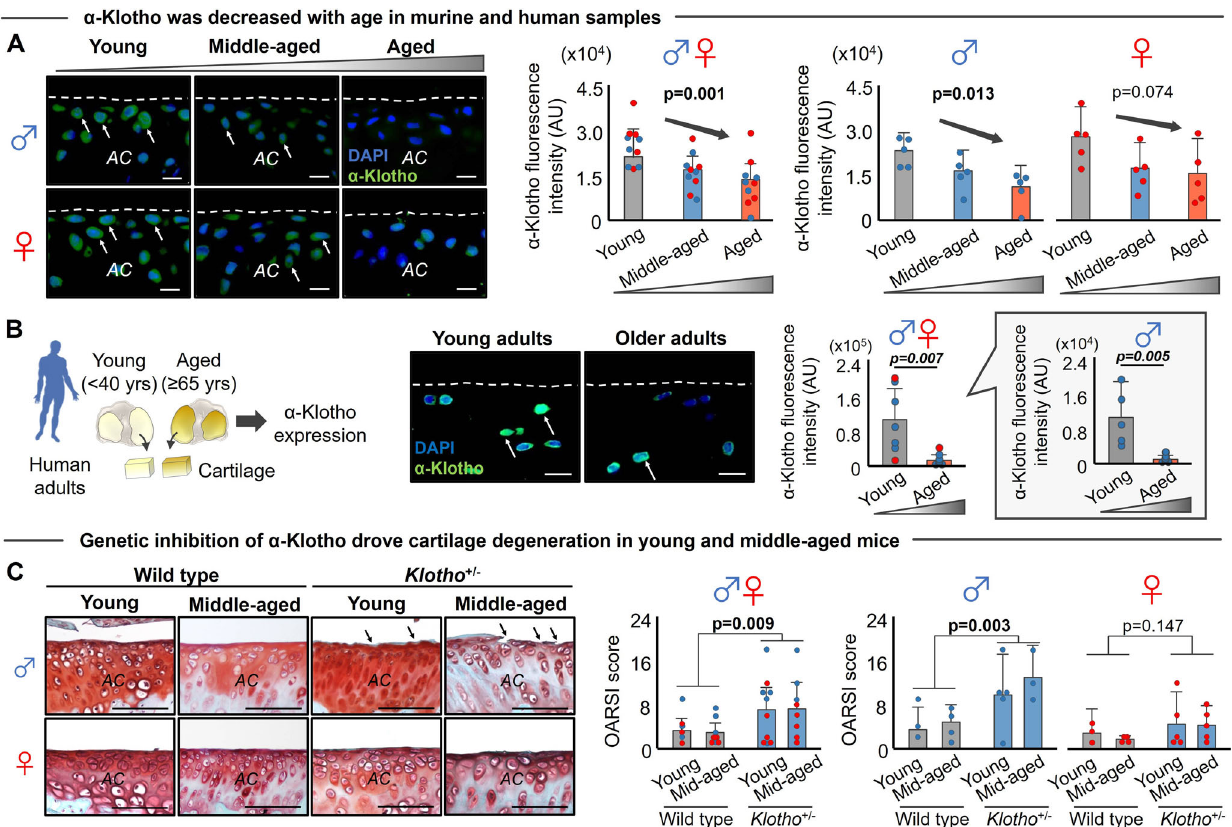
Fig. 2 | Age-related declines in α -Klotho are associated with cartilage degen- eration in male mice. A Aging induced a progressive decline of α -Klotho in the murine medial tibia ( n =5/sex/age). White arrows indicate α -Klotho-positive chondrocytes.White dashed lines indicate cartilage surface. ACarticularcartilage. Scale bar: 10 μ m. α -Klotho expression per cell was quanti fi ed by immuno- fl uorescence (50 – 100 cells per mouse). B Cartilage in older adults ( ≥ 65 years old; 71.9±2.91 years; n =7 [1 female]) displayed reduced α -Klotho expression com- paredtoyoungadults(<40yearsold;27.6±6.85years; n =7[2females]).Scalebar: 20 μ m. α -Klotho expression per cell was quanti fi ed by immuno fl uorescence